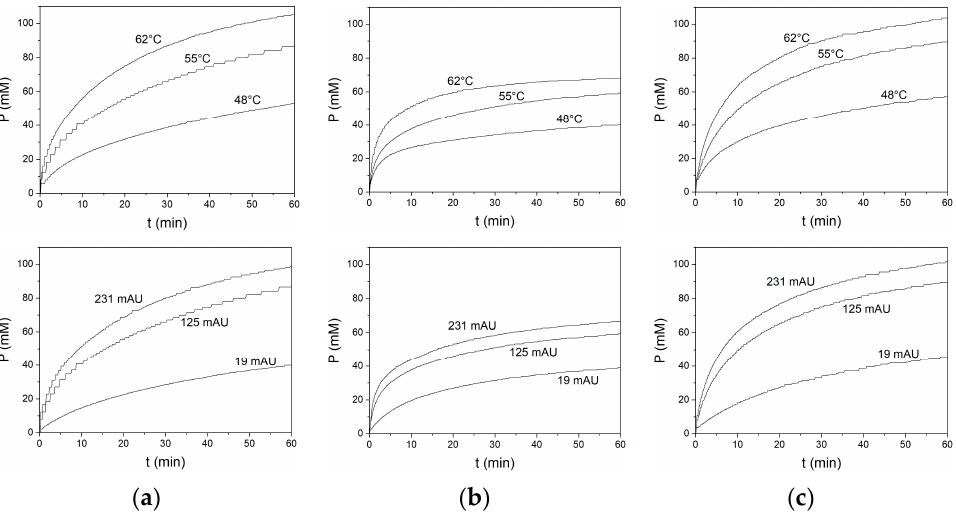
Figure 1. Experimental curves of milk protein hydrolysis with ( a ) Alcalase, ( b ) Neutrase and ( c ) Protamex at different temperatures (125 mAU) and protease concentrations (55 °C). These results agree with previous observations concerning Neutrase thermal